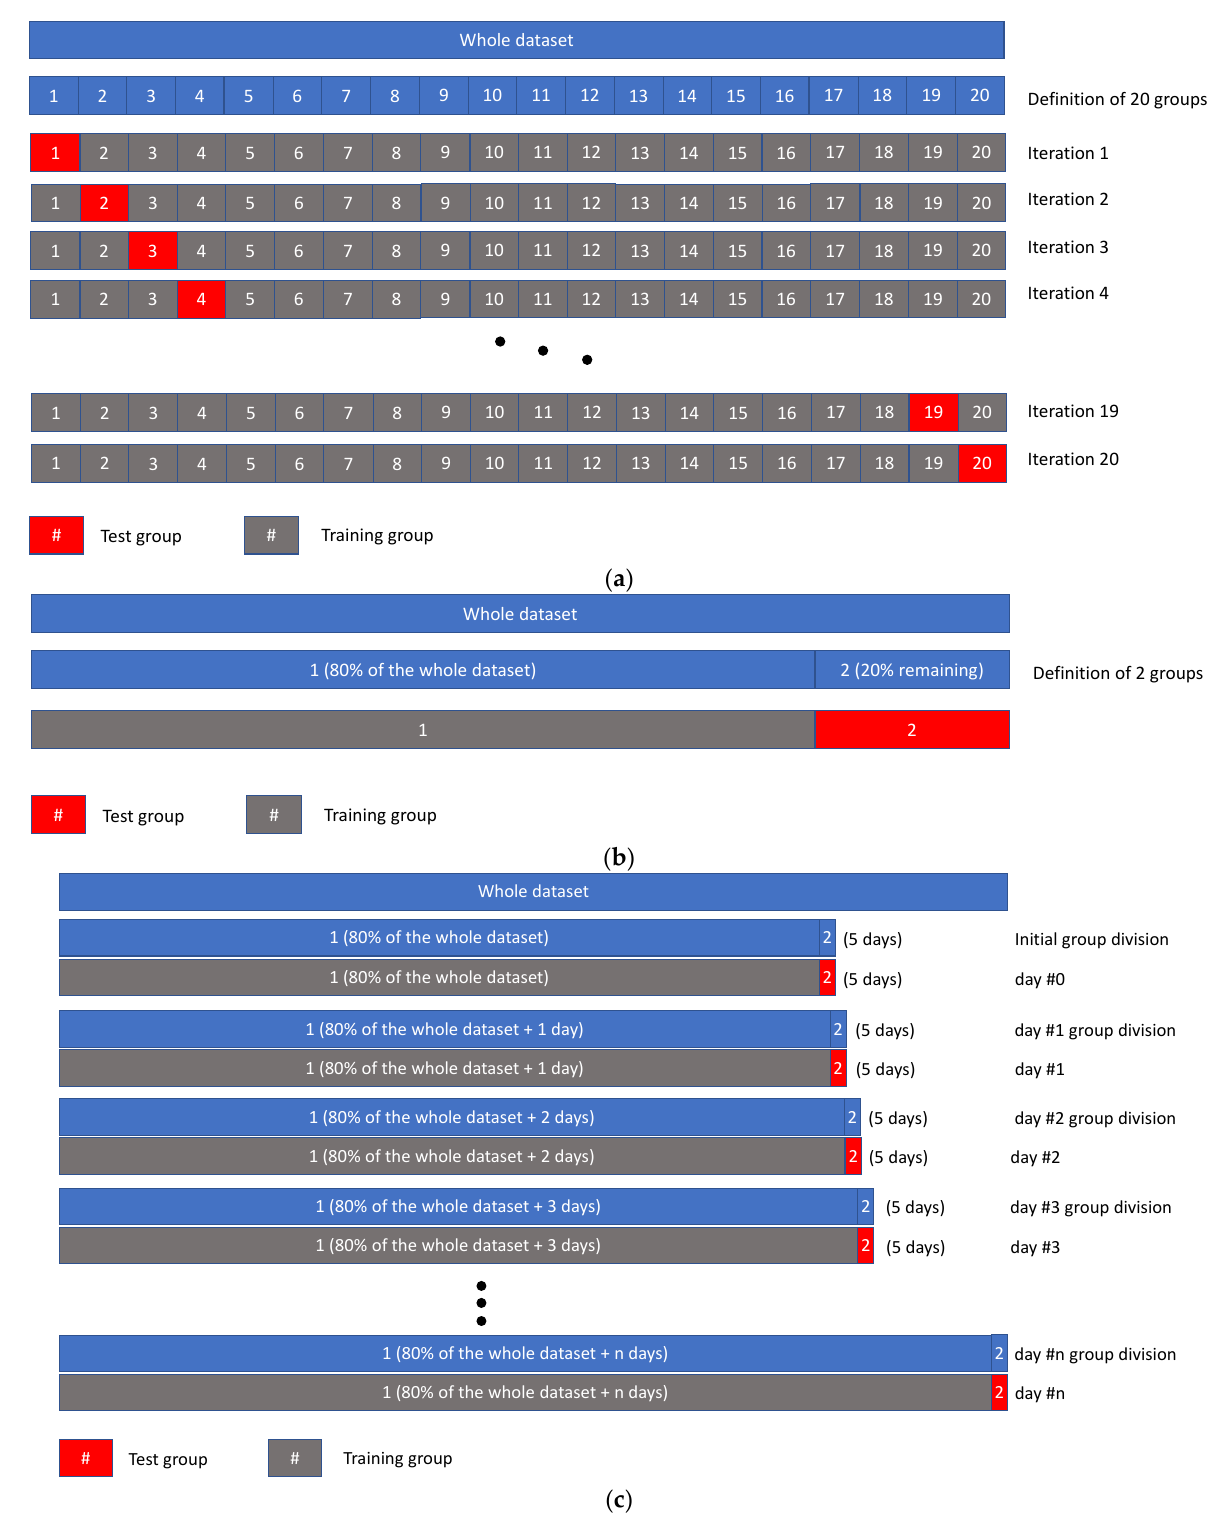
Figure 4. Division of the datasets for the different scenarios. ( a ) Scheme of the 20-fold cross-validation procedure used in scenario A. ( b ) Scheme of the scenario B. ( c ) Scheme of the scenario